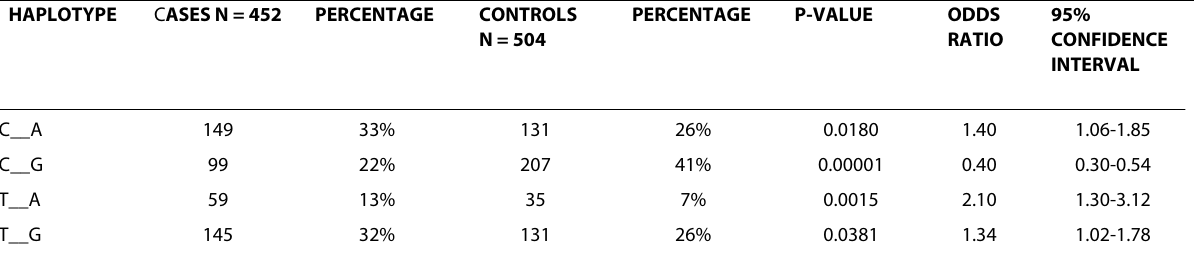
Table 3: Frequency of common GRIA1 haplotypes in migraine patients compared with healthy controls. HAPLOTYPE